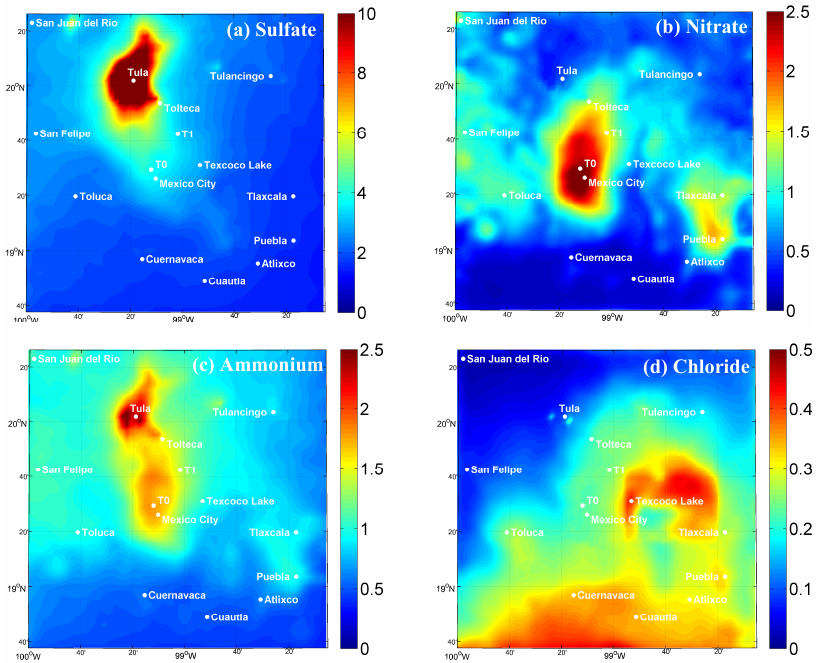
Fig. 3. Predicted average ground level concentrations of PM 1 (a) sulfate, (b) nitrate, (c) ammonium, and (d) chloride (µgm − 3 ) during 4–30 March 2006.